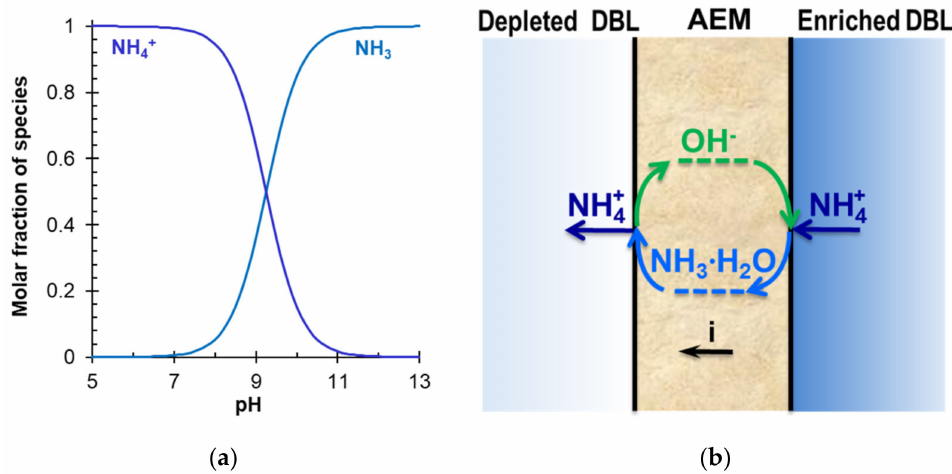
Figure 22. Distribution of mole fractions of NH 4+ and NH 3 species in aqueous solutions depending on pH ( a ) and a schematic representation of the mechanism of ammonium cations “facilitated” diffusion through an anion-exchange membrane due to higher pH values in AEM than into the external solution ( b ). Reproduced with permission [205]. Copyright 2022